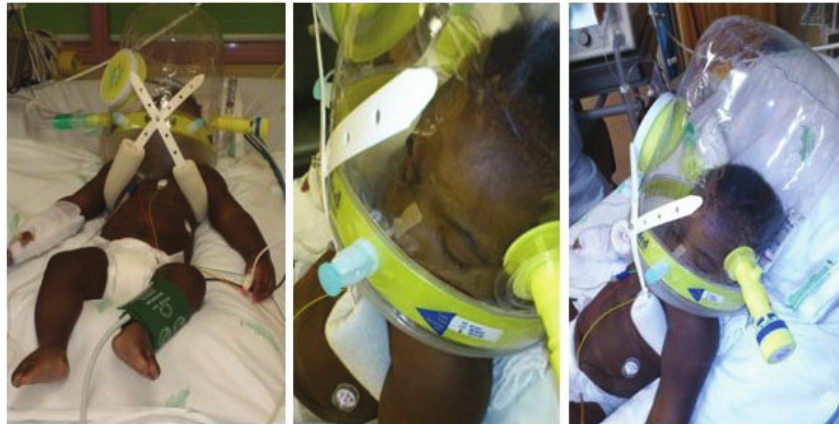
Figure 2: Helmet interface use with significant comfort for the patient.